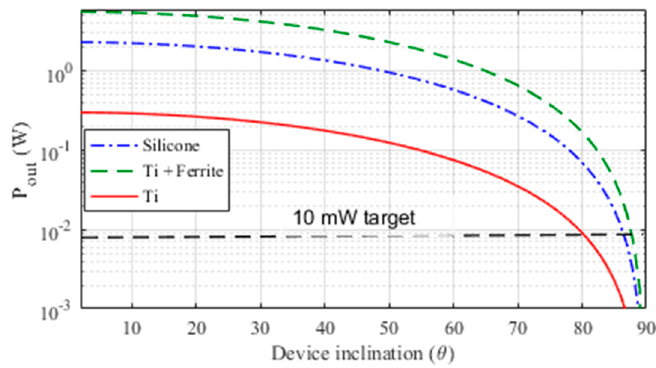
Figure 15. Output power Pout vs. inclination angle θ .